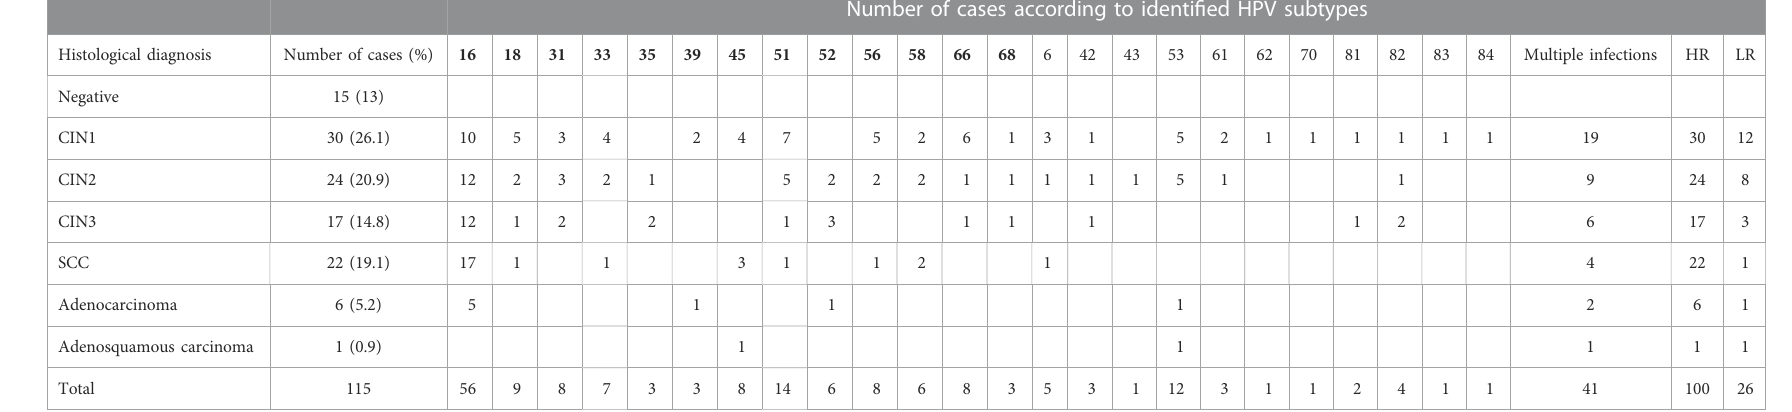
TABLE 2 Outcomes of histological examination for the study population and HPV genotyping results. HPV subtypes in bold indicate high-risk subtypes. HR, high risk (number of women); LR, low risk (number of